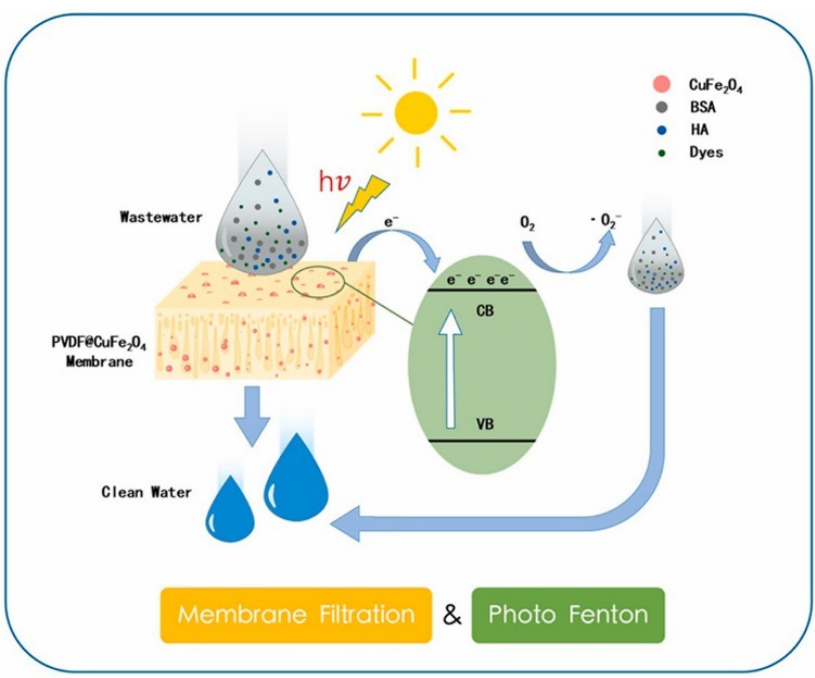
Figure 3. Schematic diagram illustrating the integration system of membrane filtration and the photo–Fenton process. BSA: bovine serum albumin; HA: humic acid. Reprinted with permission from Ref. [72]. Copyright 2019, Elsevier.